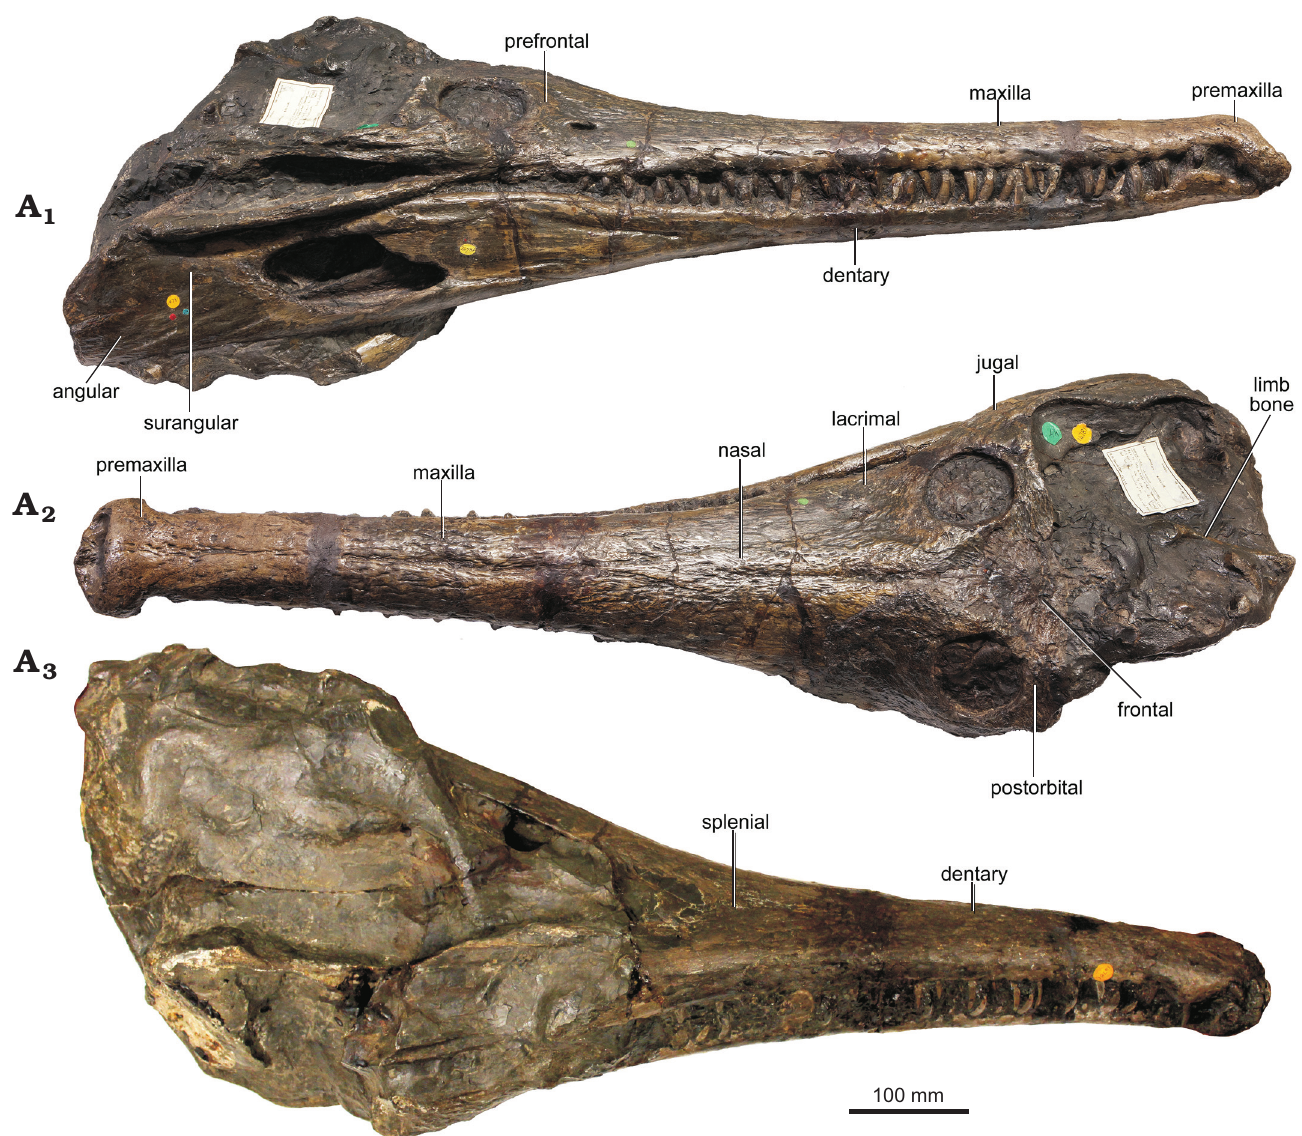
Fig. 2. Teleosauroid thalattosuchian Mystriosaurus laurillardi Kaup, 1834 (NHMUK PV OR 14781, holotype of Steneosaurus brevior Blake, 1876, lower Toarcian of Whitby (Yorkshire, UK); skull in lateral (A 1 ), dorsal (A 2 ), and ventral (A 3 )